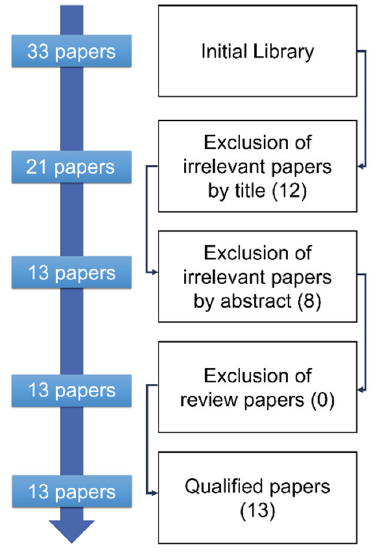
Figure 1. Literature Review methodology.